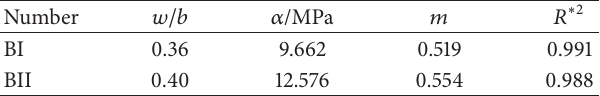
Table 5: Regression parameters ( 𝛼, 𝑚 ) and correlation coefficients ( 𝑅 ∗ ) of moisture characteristic curves for concrete